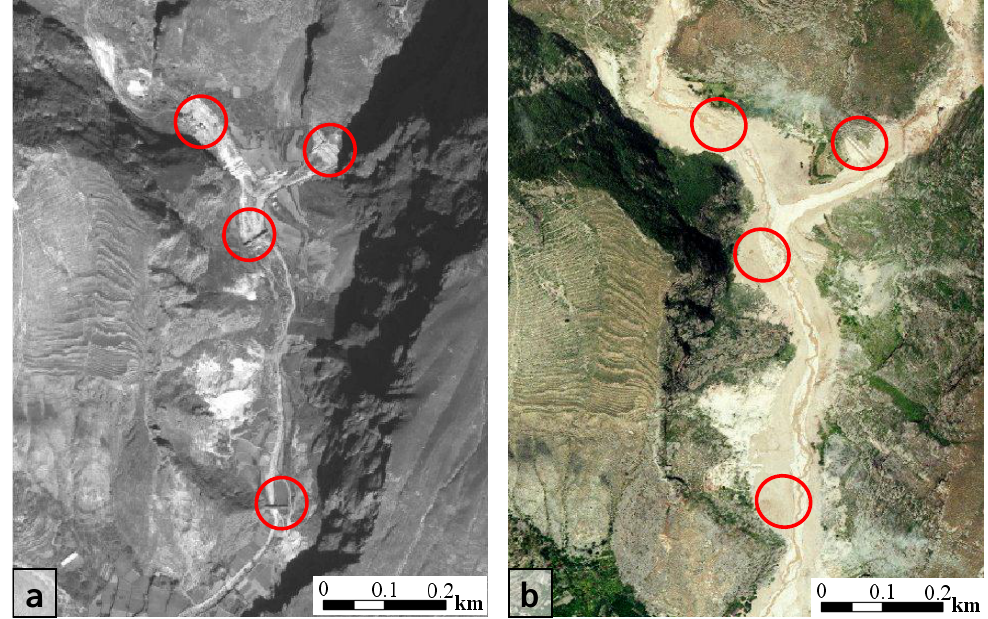
Fig. 10. Comparison of the imageries prior to and after the event showing that four previous debris flow control structures were destroyed in the Sanyangyu torrent. ( a : Worldview image taken on 16 May 2010 prior to the event; b : Quickbird image taken on 15 August 2010 after the Zhouqu debris flow event.)